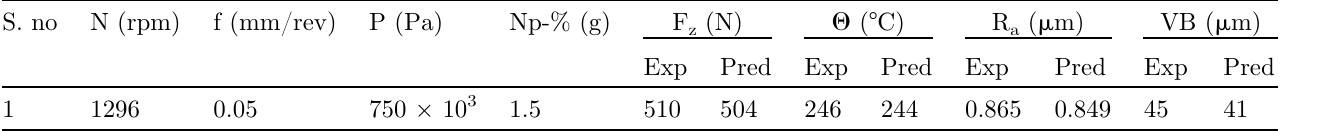
Table 10. Best solutions for optimization con fi rmation experiment and results.